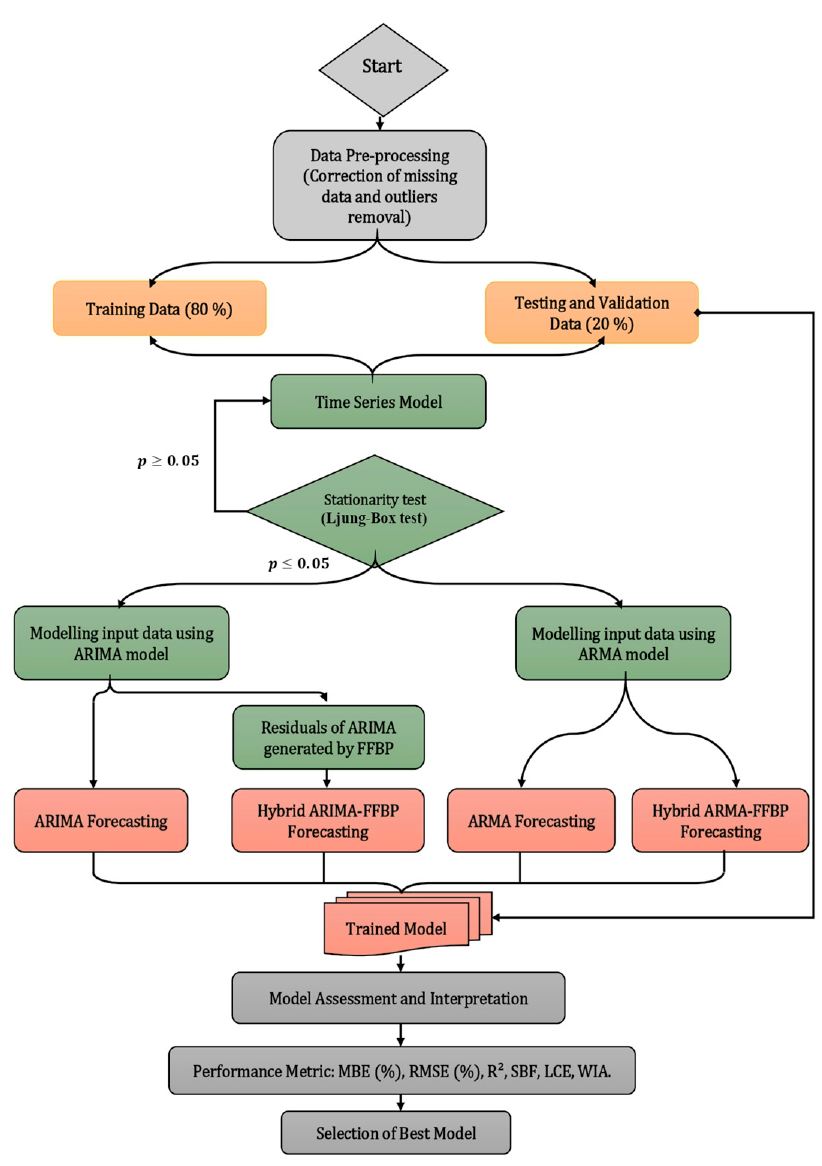
- The models were built and divided into simple (ARMA, ARIMA, and FFBP), and hy- brid methods (hybrid ARMA-FFBP and hybrid ARIMA-FFBO models; orange color). - The obtained result (grey color) was evaluated and interpreted by using various statistical metrics in order to choose the best model, which presents the lowest value of MBE (%), RMSE (% Sd (%), AIC, and BIC and the highest values of R 2 , SBF, LCE, WIA.